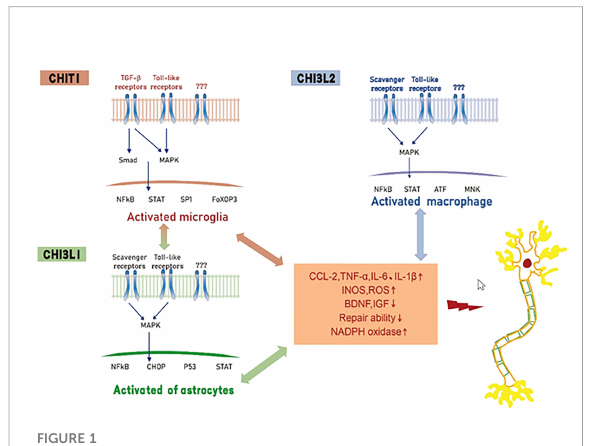
FIGURE 1 Hypothesisof mechanismsof Chitinaseinducedneurotoxicity in ALS. CHIT1,CHI3L1andCHI3L2activate glial cellsandmacrophagesby interactingwithreceptors (e. g. toll-likereceptors, transforming growth factorbetaorscavengerreceptors), resultingintherelease of pro-in fl ammatorymediators, inhibitionofneurotrophicfactor synthesisanddecreasedtissuerepairfunction.